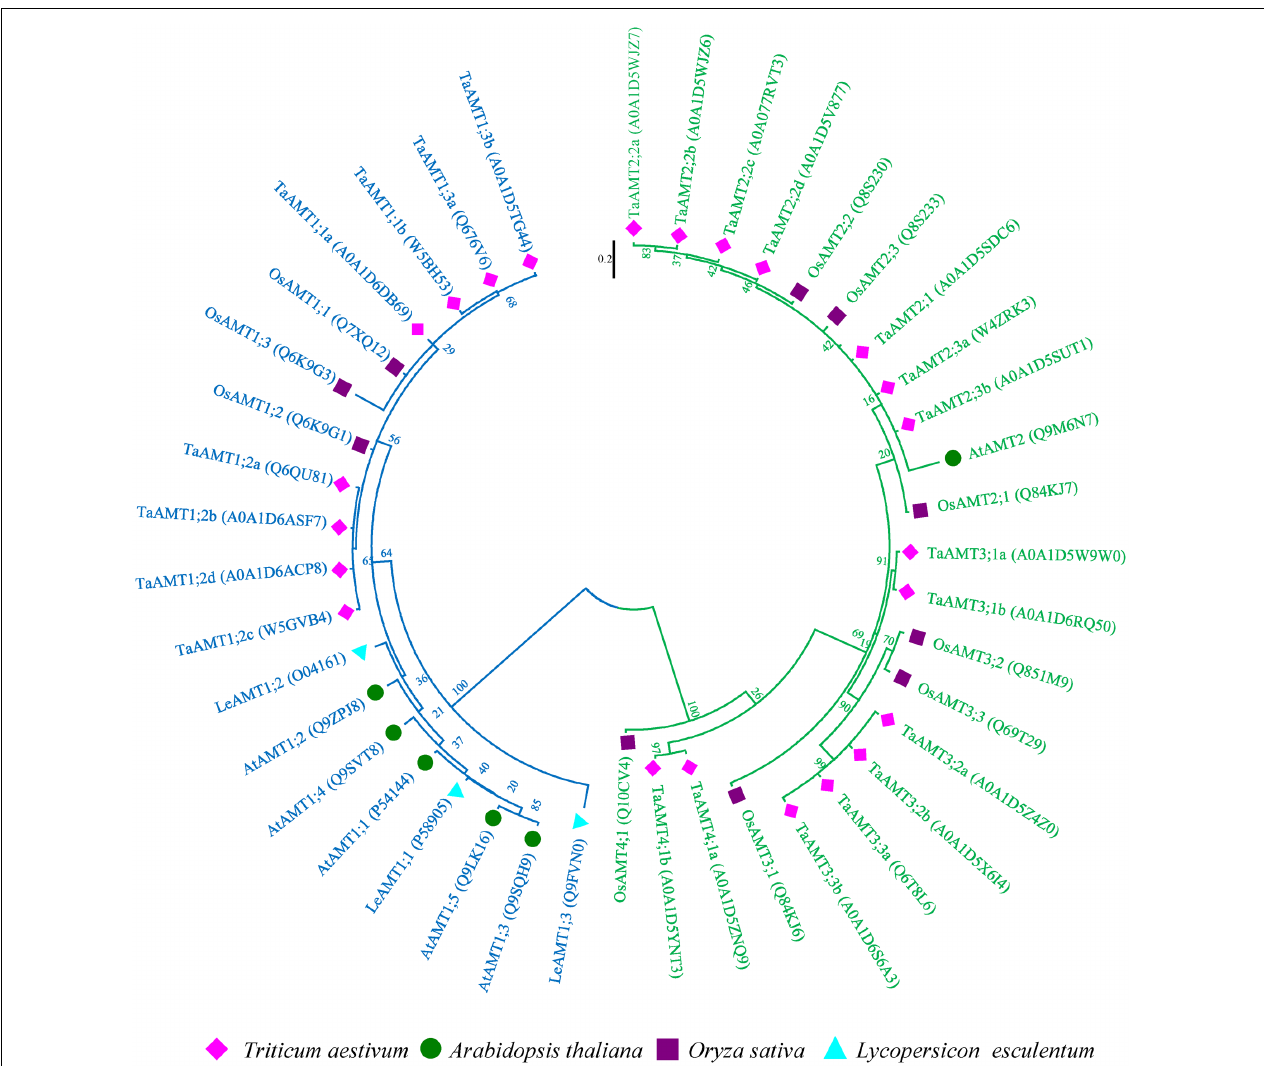
FIGURE 1 | Phylogenetic tree of AMTs from Oryza sativa , Arabidopsis thaliana , Triticum aestivum , and Solanum lycopersicum. The phylogenetic tree was constructed using the maximum-likelihood method. The unrooted tree was generated using ClustalW in MEGA 7.0 using AMT amino acid sequences from O. sativa (OsAMTs; dark blue color), A. thaliana (AtAMTs; dark orange color), T. aestivum (TaAMTs; light green color), and S. lycopersicum (LeAMTs; light blue color). AMT1s are marked with blue and others are marked with green.